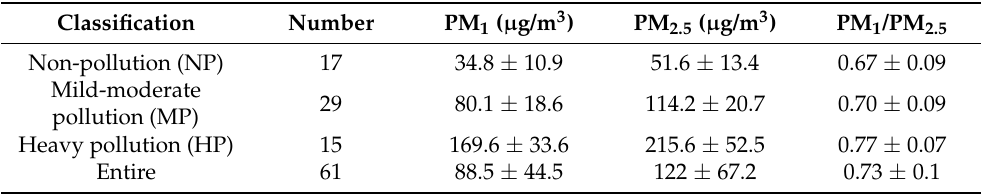
Table 1. Concentrations of PM 1 and PM 2.5 on non-pollution, mild-moderate pollution and